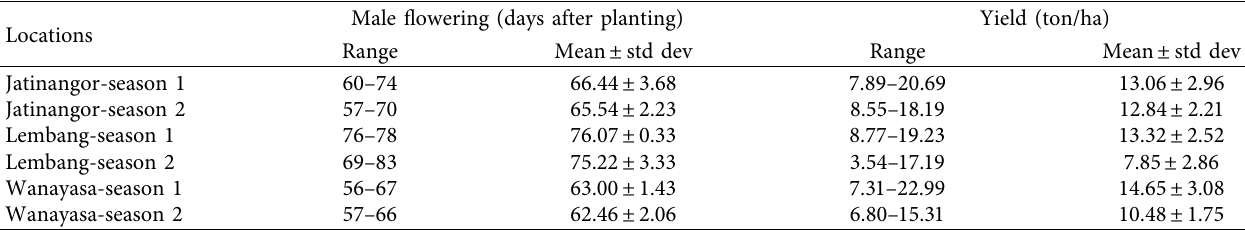
Table 1: Range, mean, and standard deviation of sweet corn hybrids for flowering and yield.